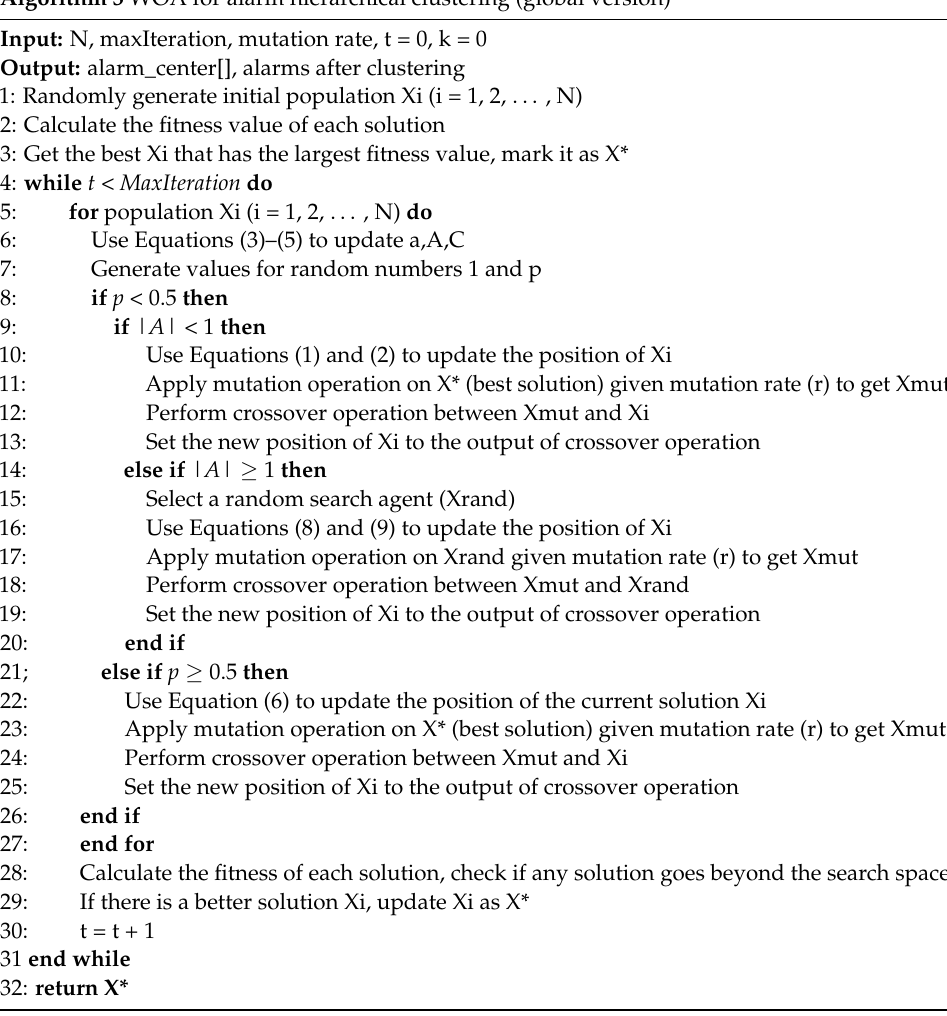
Figure 13. Alarm reduction framework flow chart based on WOAHC-G. The algorithm pseudocode of WOAHC-G is shown in Algorithm 3 Algorithm 3 WOA for alarm hierarchical clustering (global